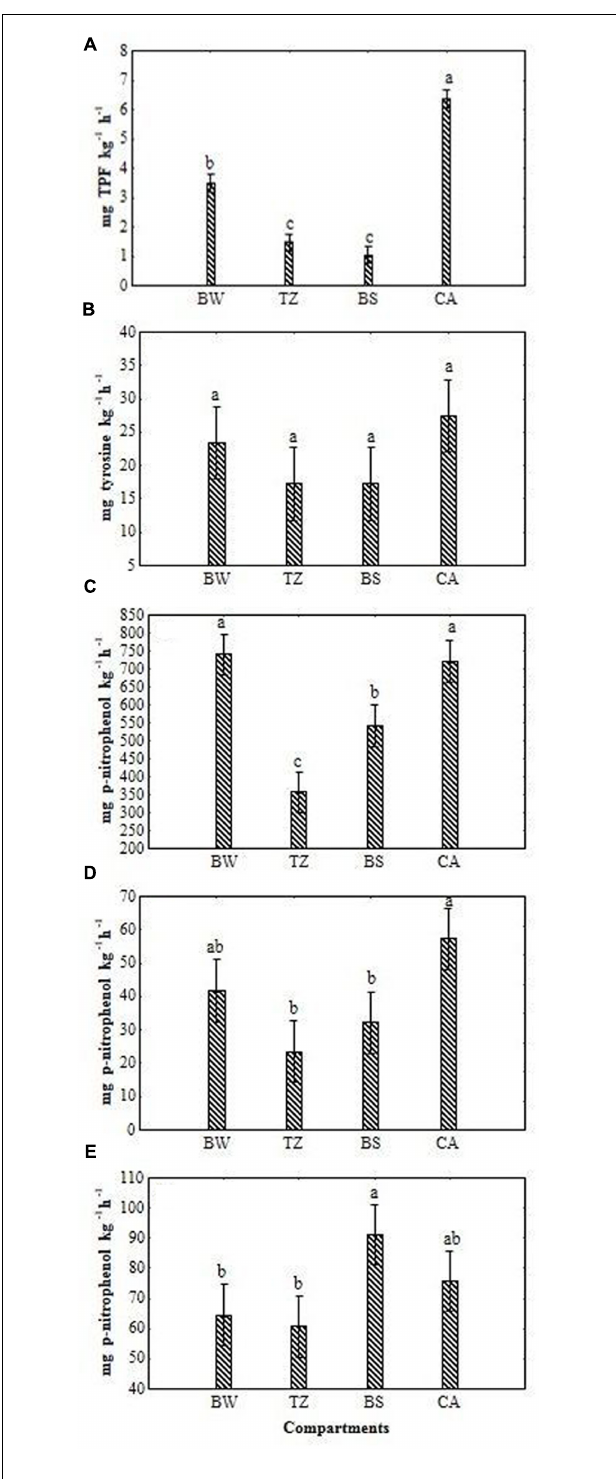
FIGURE 1 | Activities of dehydrogenase (A), protease (B), β -glucosidase (C), alkaline phosphomonoesterase (D) and acid phosphomonoesterase (E) for different compartments of burrow system (BW, burrow wall; TZ, transitional zone; BS, bulk soil; CA, cast aggregates). Error bars represent 0.95 confidence intervals. The different letters indicate significant differences between the compartments at P <